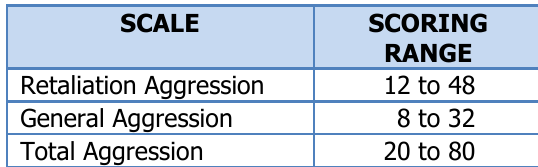
Scale for Scoring Responses to